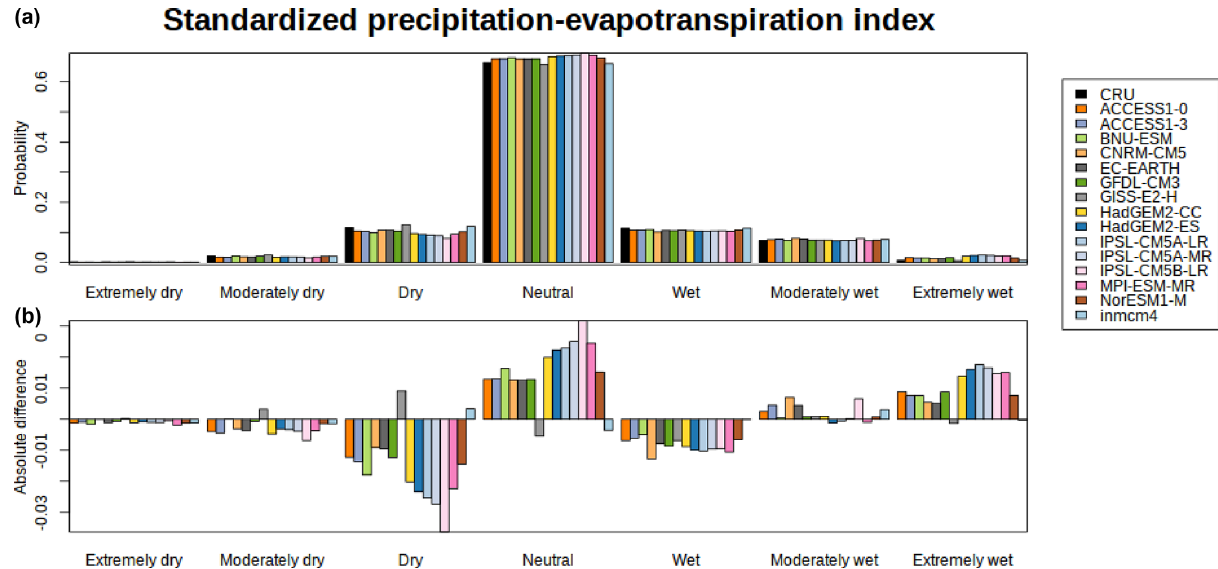
Figure 4. Output from the SPEI diagnostic in recipe_spei.yml with globally averaged histograms of SPEI over land areas, weighted by the cosine of latitude for a selection of CMIP5 models and using gridded observations from CRUts4.01. (a) Absolute values and (b) bias of all models compared to CRUts4.01; for details see Sect.